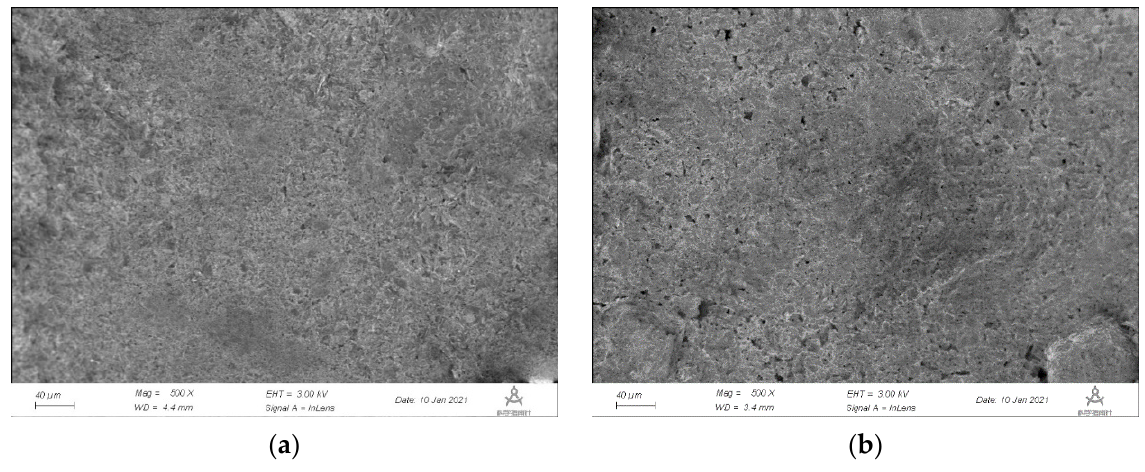
Figure 10. Comparison of void conditions under natural curing and 400 W microwave curing conditions. ( a ) Natural curing for 20 days; ( b ) microwave 400 W curing for 500 min.